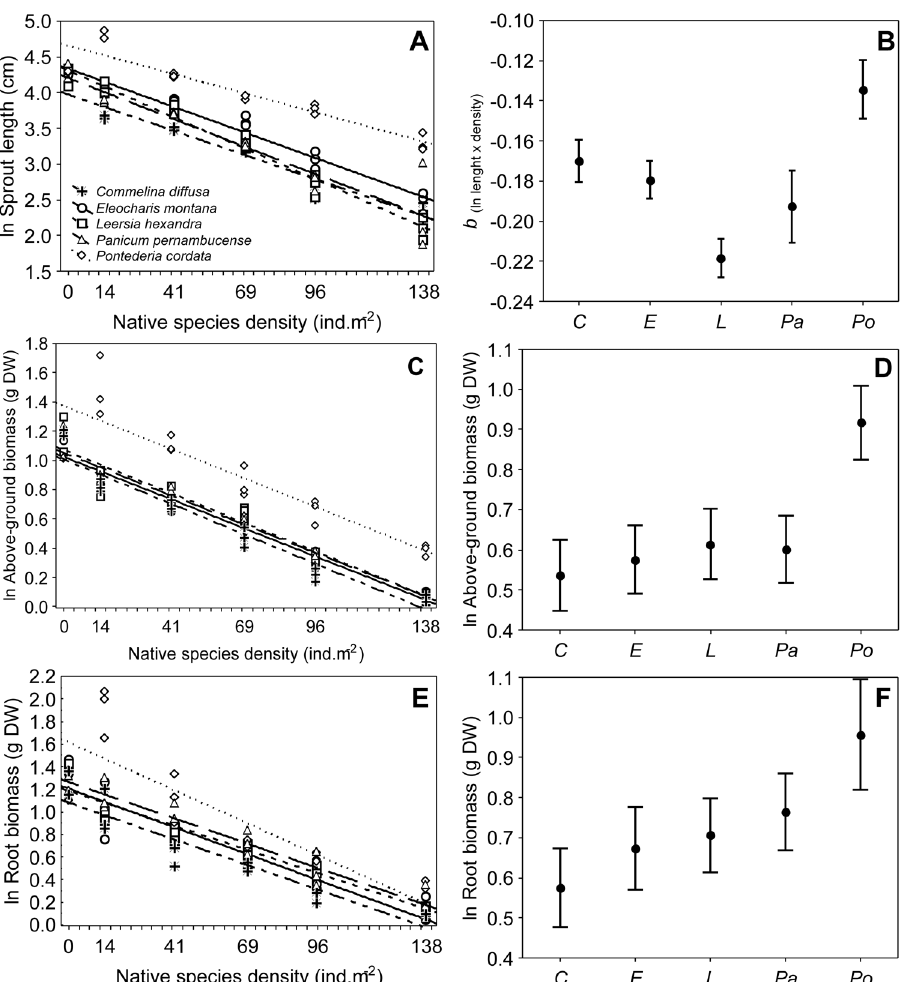
Figure 2. Effects of the densities of five native species on the exotic species. Relationships between native species densities and Urochloa arrecta sprout length (A) and aboveground (C) and root (E) biomass. The slopes of the relationships between native density and U. arrecta length (B) and the adjusted means ( 6 SE) of aboveground (D) and root biomass (F) are also shown. The values shown in A, C and E represent the means for each tray obtained from the monocultures used in our second experiment.